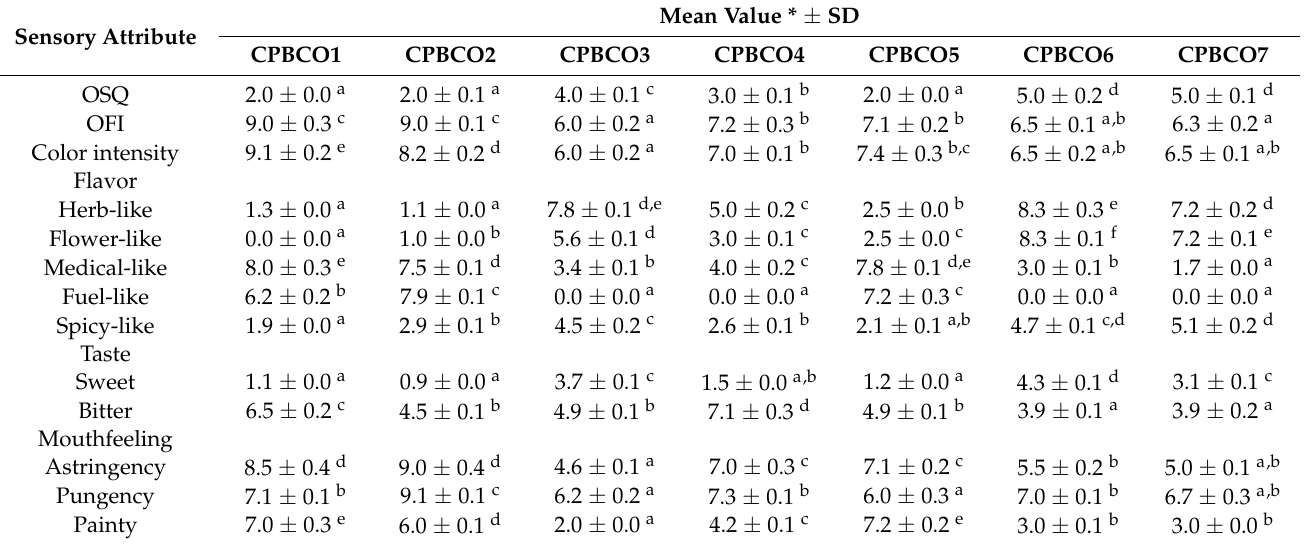
Table 7. Means for the scoring of the overall sensory quality and sensory attributes.